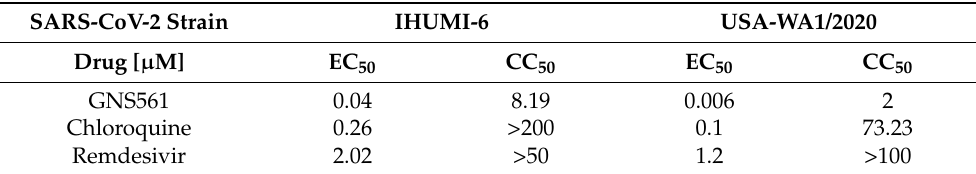
Table 1. Antiviral activity and cytotoxicity of GNS561, chloroquine, and remdesivir against SARS- CoV-2 in Vero E6 cells. After 2 h of drug treatment with different doses, Vero E6 cells were infected with SARS-CoV-2 virus, IHUMI-6 and/or USA-WA1/2020 strains (MOI 0.1), for 24 h. The half- maximal effective concentration (EC 50 ) was investigated using qRT–PCR in µ M. The half-maximal cytotoxic concentration (CC 50 ), tested in the presence of the drug only, was assessed using a viability assay and addressed in µ